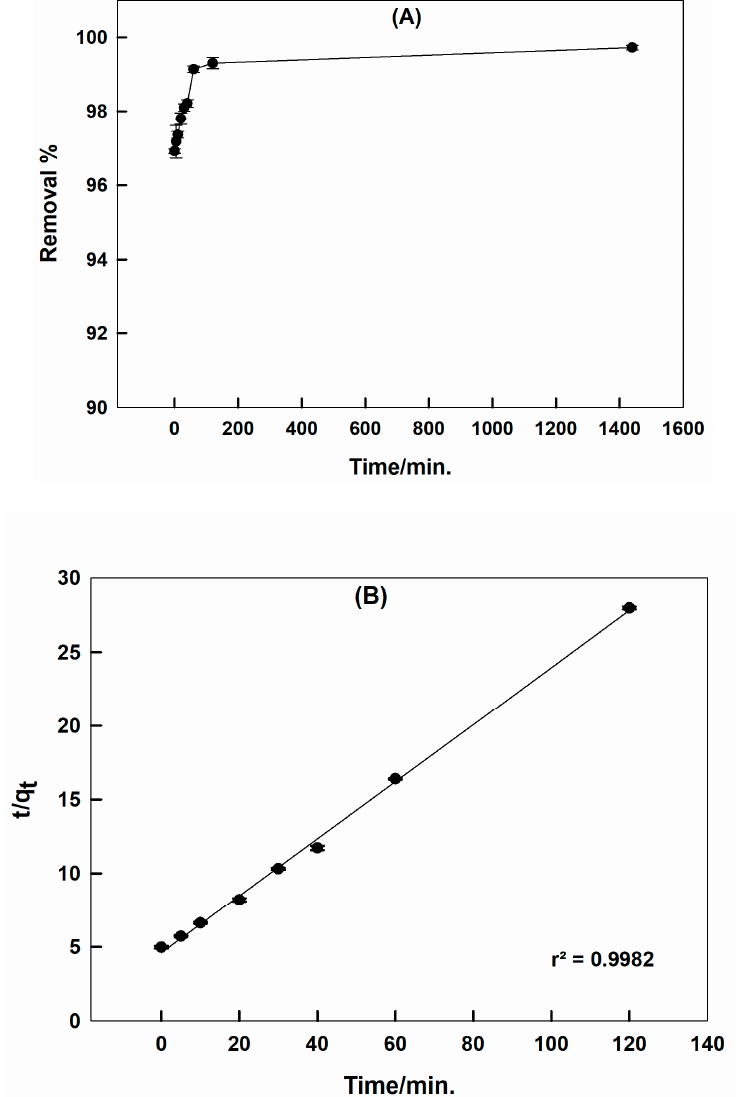
Figure 5. The relation between the CR removal % by CTAB-capped La 0.9 Sr 0.1 FeO 3 and the contact time; pH = 6, the dye concentration = 30 ppm, at 25 ° C (A), and pseudo 2 nd order model